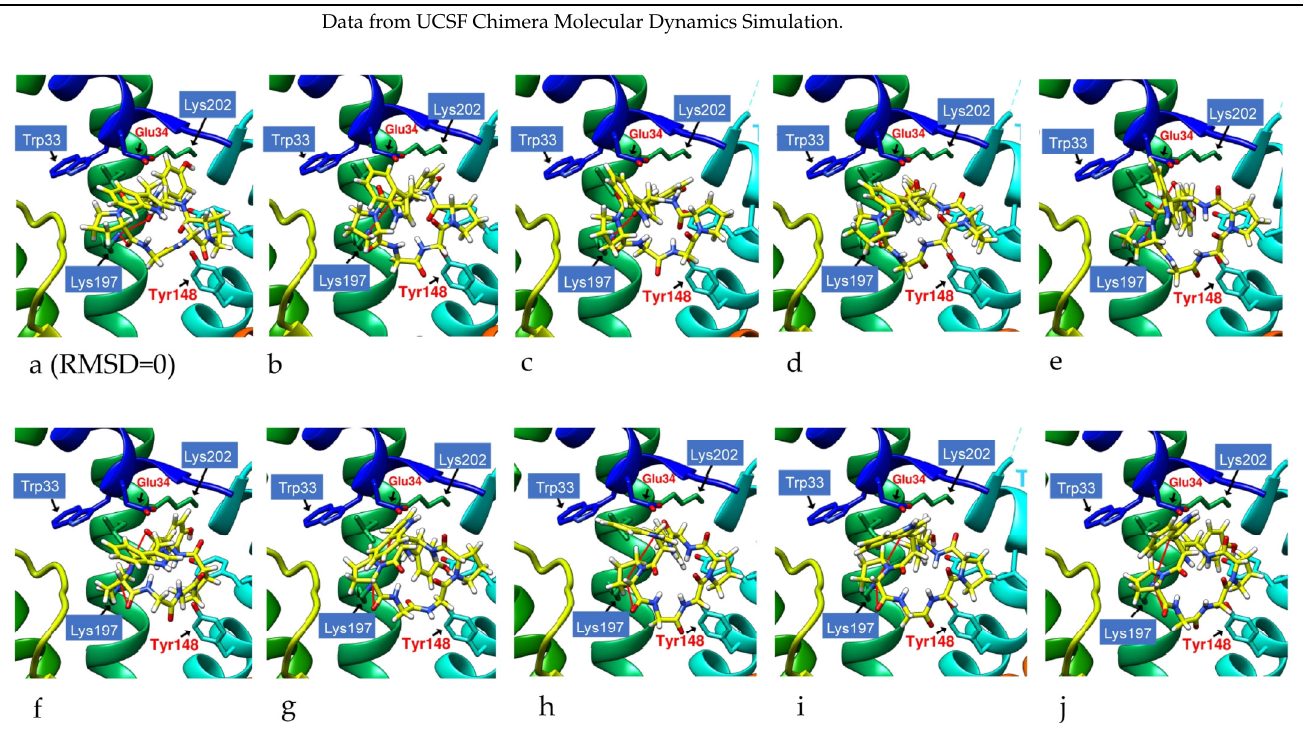
Figure 15. DdC molecular dynamics simulation series with H-bond (red-line) trajectory tracing. Over the course of the dynamic simulation of DdC in GLP-1R, the configuration gradually changes. See images starting from ( a ) (RMSD = 0), through ( b – i ) to ( j ). As the RMSD increases, the original hydrogen bonds are weakened by the increase in bond length.